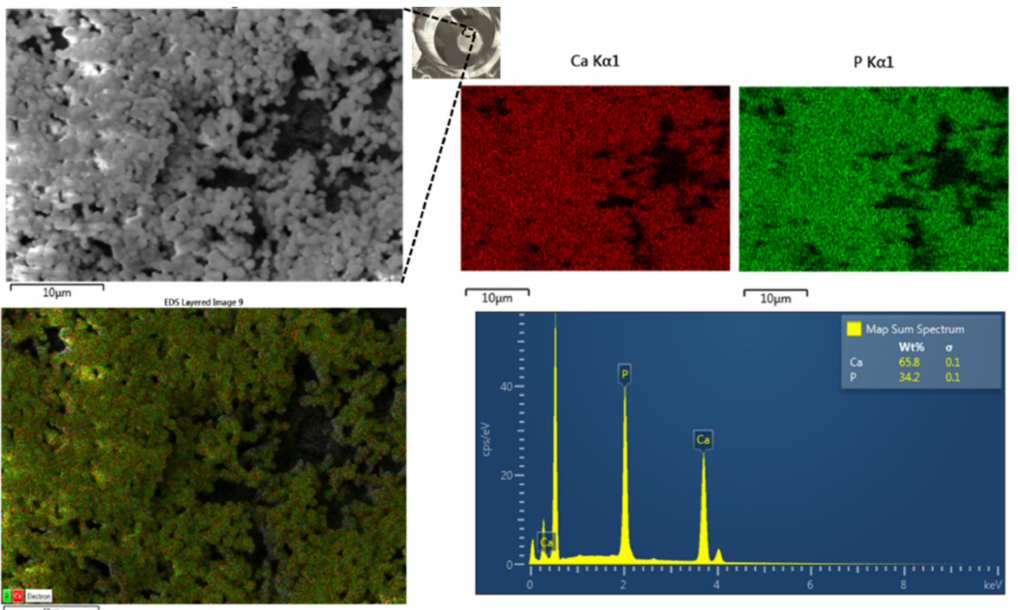
Figure 7. Characterization of mineralized disc surface using SEM-EDX. SEM image and EDX of K-GSGGG-HABP:AMPM7 (3:7) adhesive disc after mineralization.